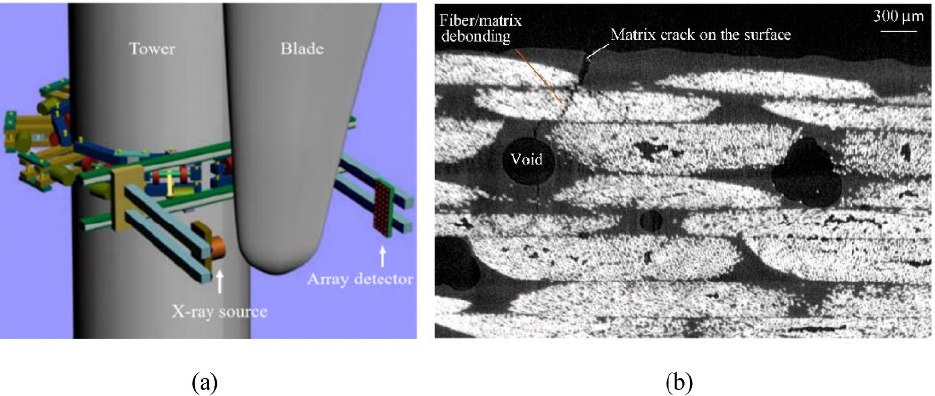
Figure 13. Radiography X-ray imaging technique for the inspection of an OWT: ( a ) illustration of the installation on a climbing robot, ( a ) and ( b ) imaging result [41].